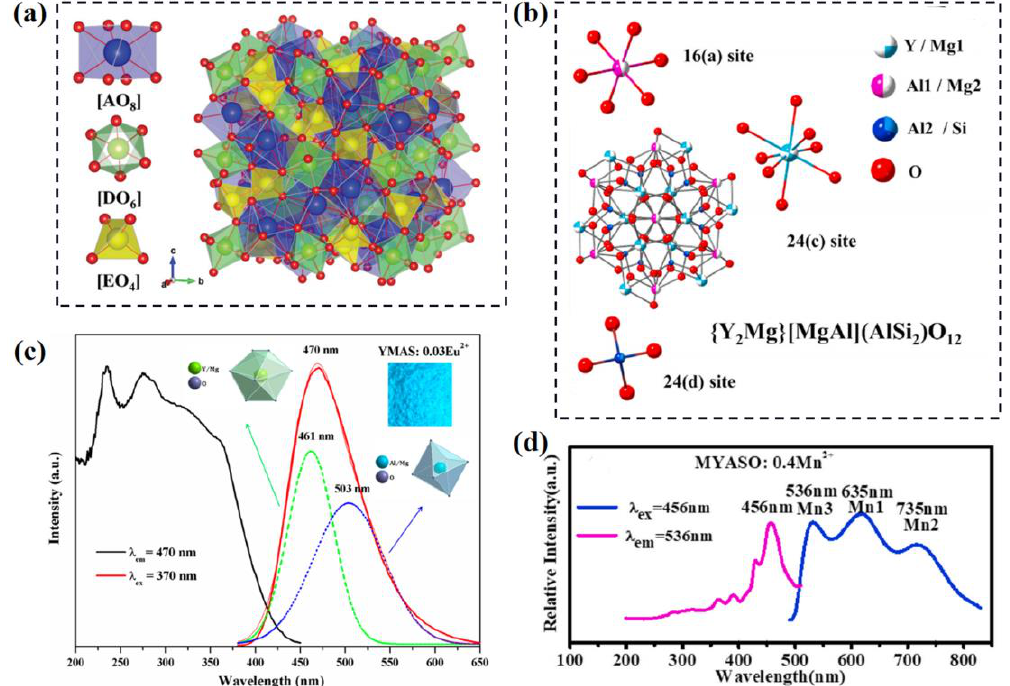
Figure 1. ( a ) The general structure model of garnet. Reprinted with permission from ref. [13]. Copyright 2021 Royal Society of Chemistry. ( b ) Crystal structure model of {Y 2 Mg}[MgAl](AlSi 2 )O 12 . Reprinted with permission from ref. [14]. Copyright 2021 Elsevier B.V. ( c ) Excitation ( λ em = 470 nm) and emission (λ ex = 370 nm) spectra of YMAS:0.03Eu 2+ phosphor. Reprinted with permission from ref. [15]. Copyright 2019 American Chemical Society. ( d ) Excitation and emission spectra of YMAS:0.4Mn 2+ phosphor. Reprinted with permission from ref. [14]. Copyright 2021 Elsevier B.V (Amsterdam, The Netherlands).